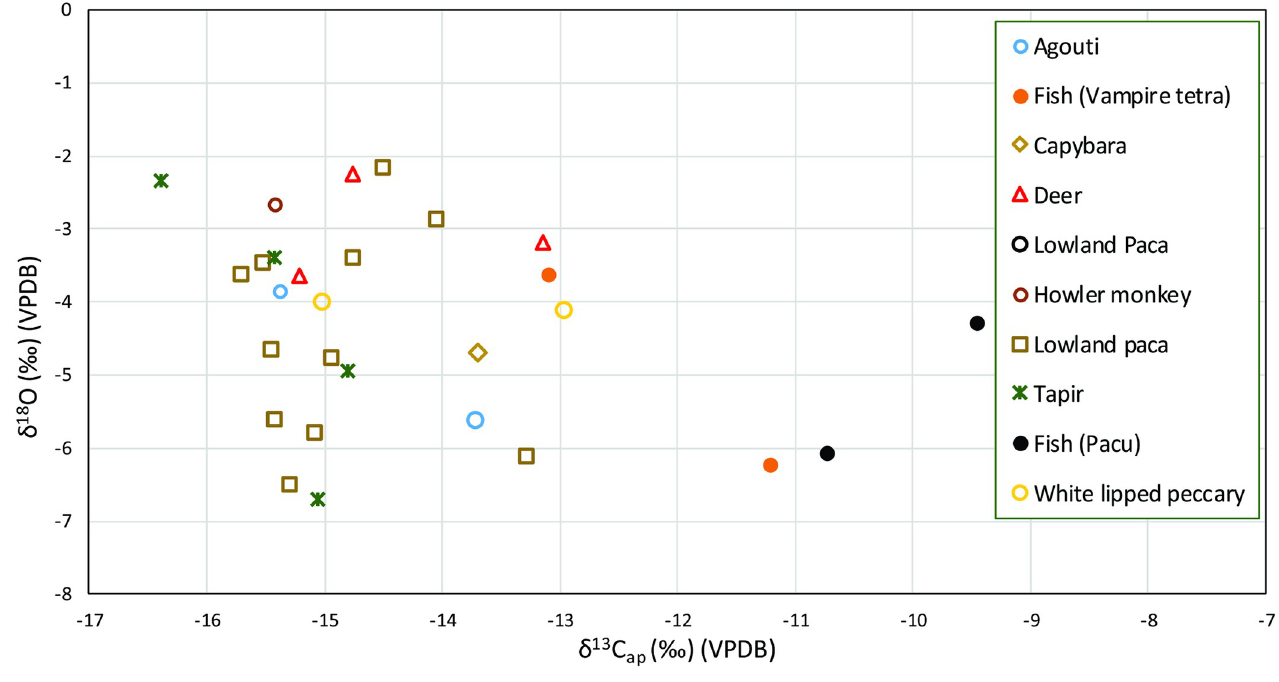
Fig 5. Faunal bulk tooth enamel δ 13 C and δ 18 O for